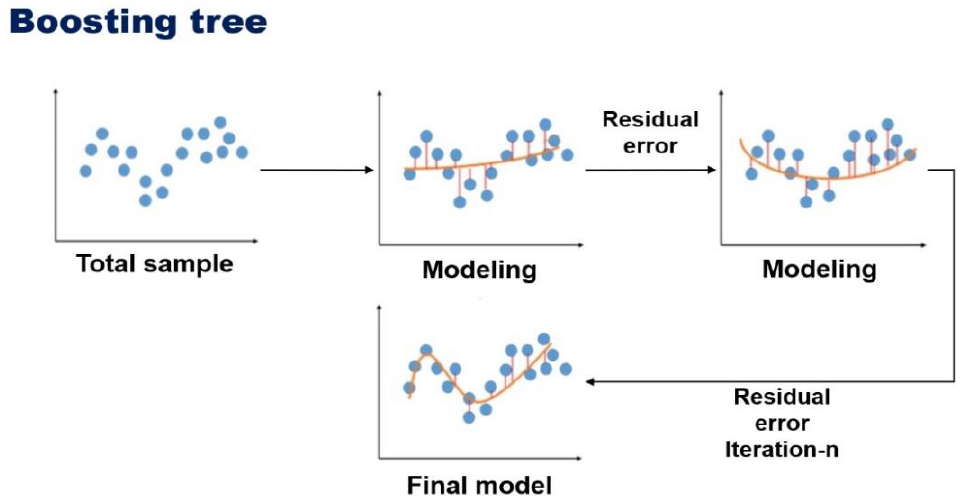
Figure 3. Modeling process of boosting tree algorithm.